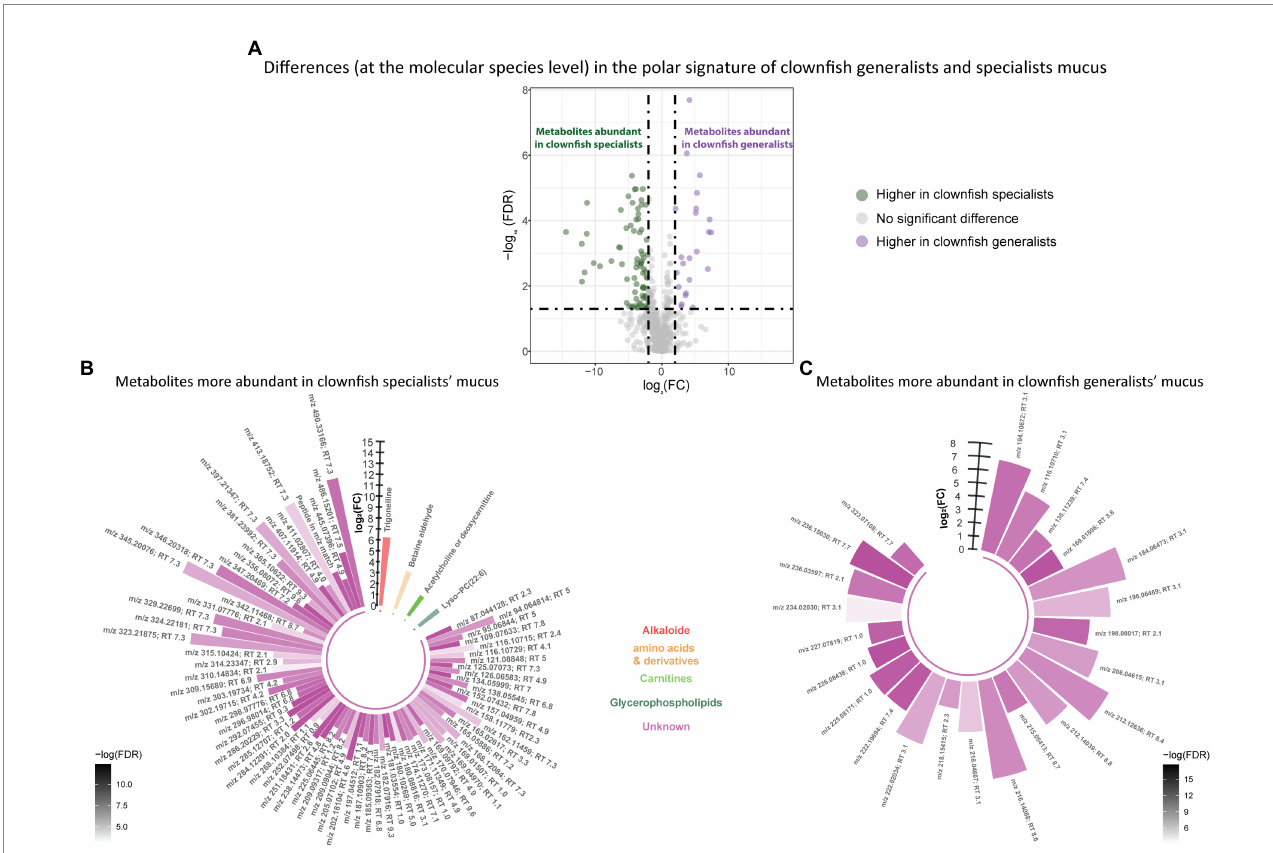
FIGURE 5 (A) Volcano plot of the global polar metabolome detected in the clownfish generalist and specialist individuals. The log 2 (Fold change) limit at − 2 and 2 highlights the lipids higher in clownfish specialists (dark green) and the lipids higher in clownfish generalists (purple). These polar features are subsequently represented in circular bar plots (B) and (C) to highlight the identified features and polar metabolite classes differing between these two clownfish groups. Each colour represents a polar metabolite class and the different shades of one colour reflect the -log(FDR) of each feature, calculated by performing a t